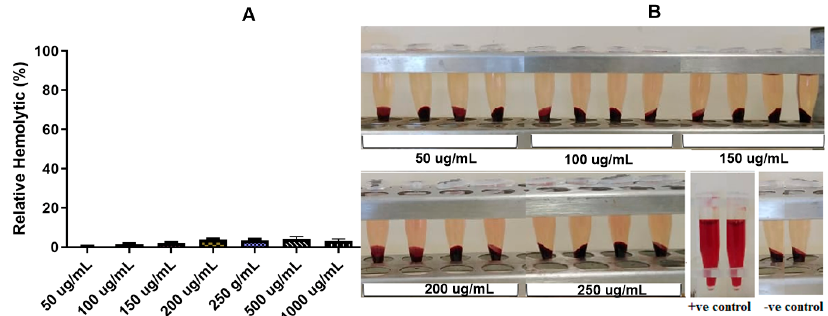
Figure 5. ( A ) Histogram expression of VCM-StBAclm-Qt 1 in blood using different concentrations as indicated and ( B ). visual observation of the hemolytic activity of VCM-StBAclm-Qt 1 at different concentrations after centrifugation. The data are the means of four replicates with standard deviations.